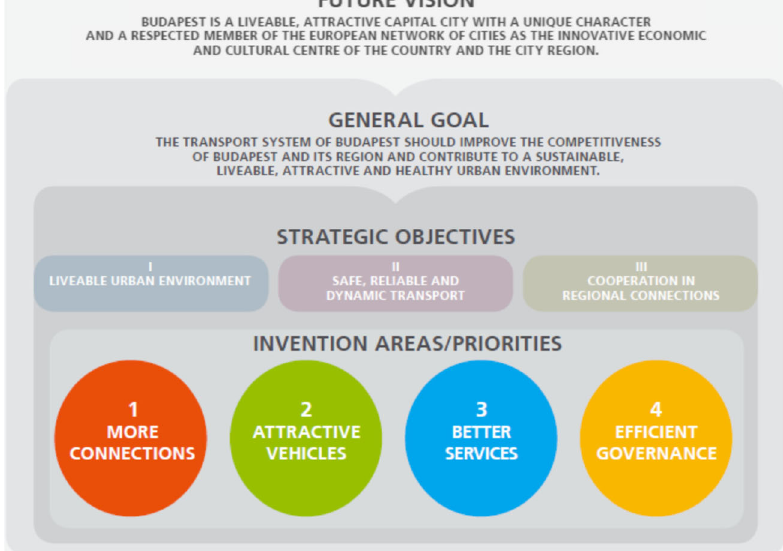
Fig. 7 Correlation between the future vision and key strategic objectives. Source: [2] BMT, 2014. pp.